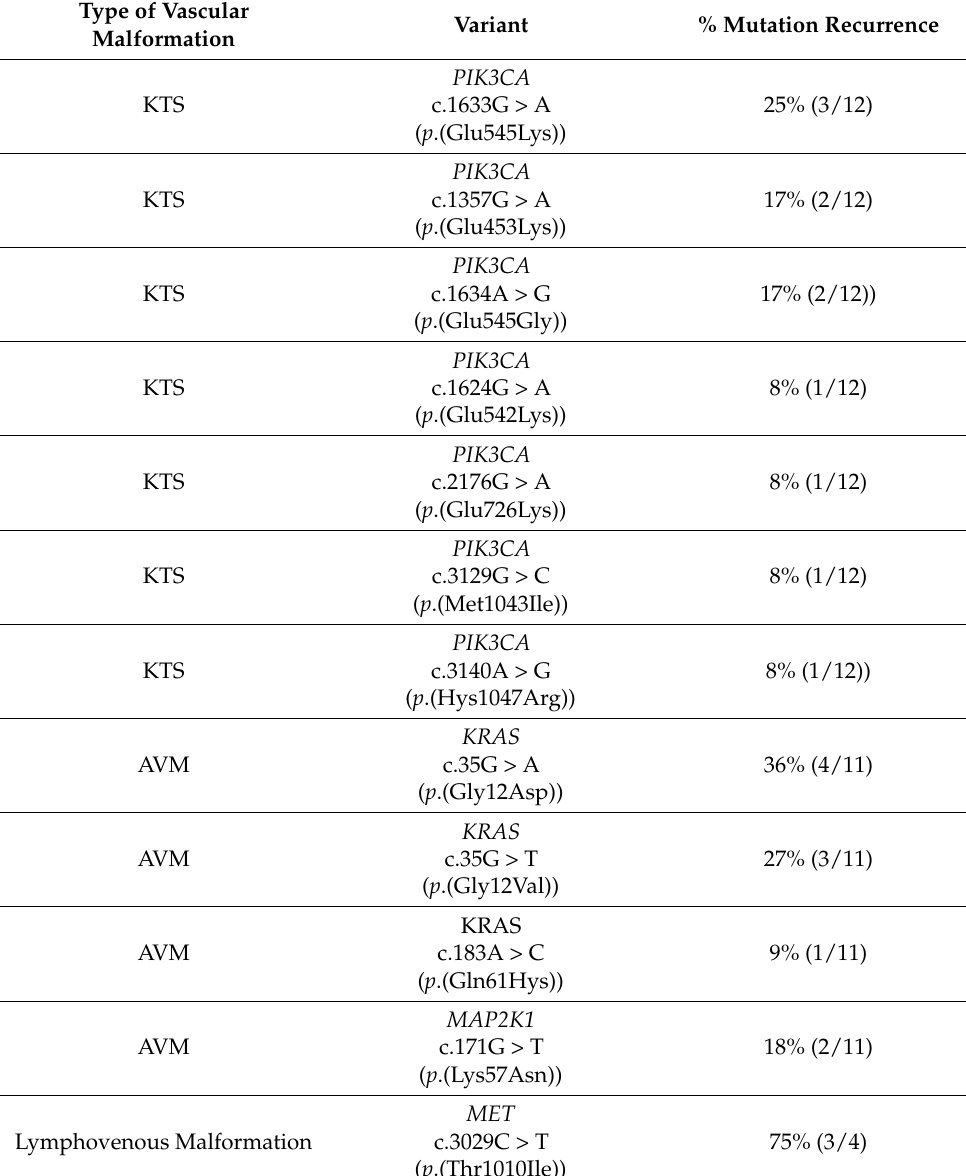
Table 3. Most recurrent somatic variants in the different types of AVMs and their frequencies in our cohort of patients. Variant type, and its frequency in our cohort, is indicated in each